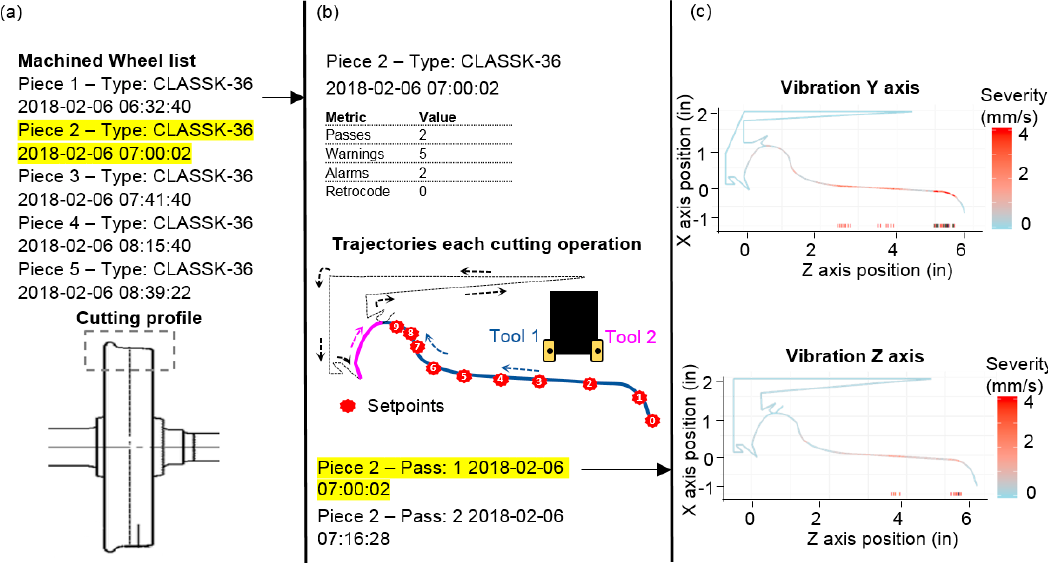
Figure 11. Data visualization for wheel cutting process fingerprint of the workpiece: ( a ) machined wheel list; ( b ) tool trajectory and reset points; ( c ) vibration severity graphs.